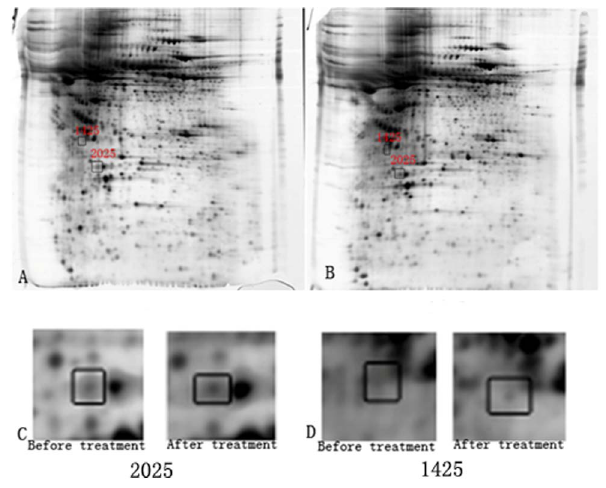
Figure 2. Plasma APOA-1 and GNAS expression before and after risperidone treatment using 2-DE. A: APOA-1 (spot ID 2025) and GNAS (spot ID 1425) expression before treatment. B: APOA-1 (spot ID 2025) and GNAS (spot ID 1425) expression after treatment. C: Plasma level of APOA-1 (spot ID 2025) was significantly increased after 8 weeks of risperidone treatment. D: Plasma level of GNAS (spot ID 1425) was significantly reduced after 8 weeks of risperidone treatment.